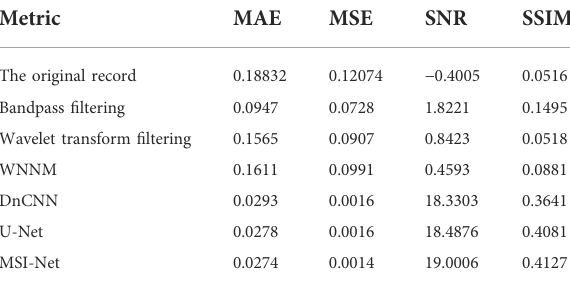
TABLE 4 Performancestatisticsof different denoising methods on the test